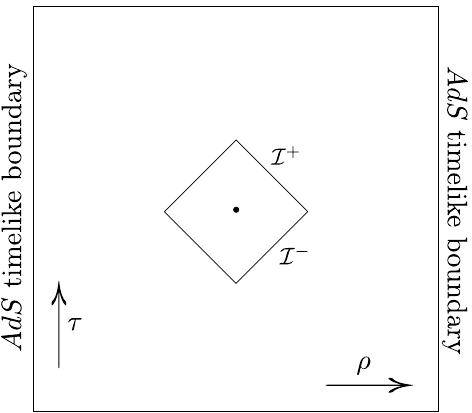
Figure 1 . The Ward identity is defined across the null surfaces of the asymptotically flat spacetime patch embedded within a larger AdS spacetime. The black dot at the center represents the black hole treated as a point particle in our scattering approximation. The effect of 1 /l 2 corrections is to perturb the asymptotically flat spacetime Ward identity defined on the surface of the